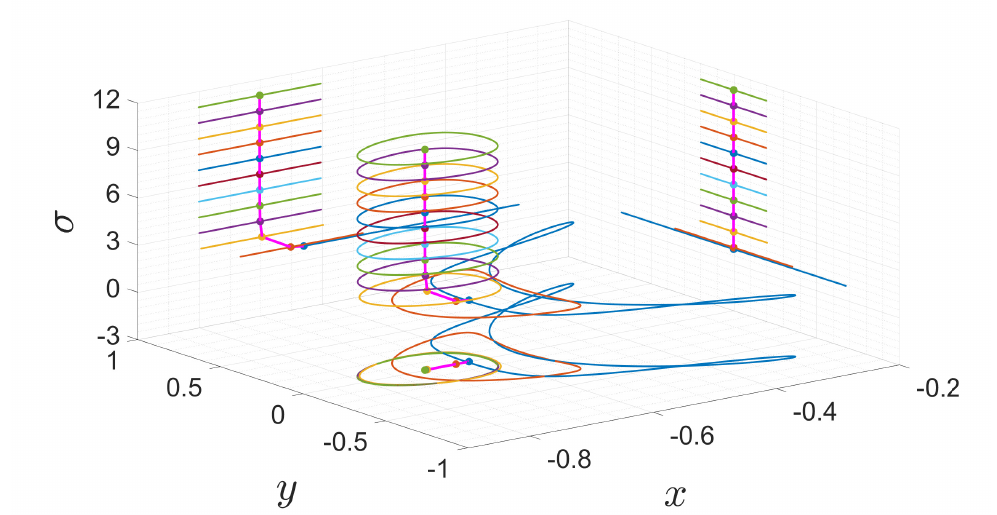
Figure 2. Approximate periodic orbits near the Lagrangian point L 3 when ( a ) σ = 1, ( b ) σ = 2, ( c ) σ = 7.82406, and ( d ) σ = 100, respectively.